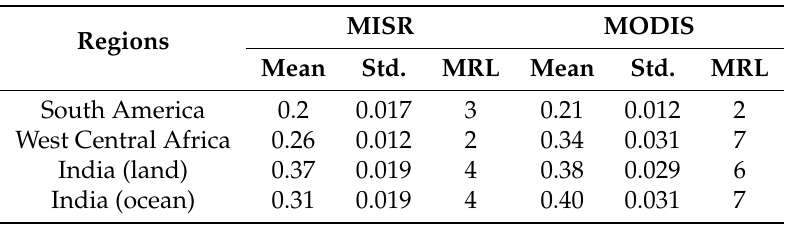
Figure 7. Time series of annual mean AODs from MISR (blue) and MODIS (red) between March 2000 and February 2017. The AODs on MISR JOINT_AS’ grid points are spatially averaged over the three green boxes in Figure 4c. ( a ) South America near the Equator. ( b ) West Central Africa. ( c ) India. Solid and dotted lines represent AODs averaged over land and ocean respectively. Table 1. The temporal mean and standard deviation (std.) of each time series in Figure 7, and the minimum record length (MRL) required to obtain a sample standard deviation less than